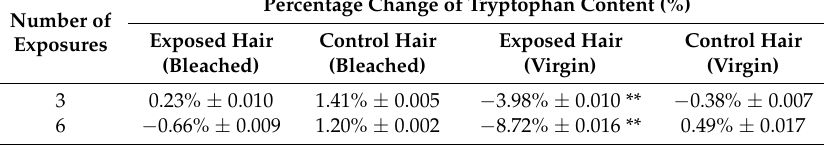
Table 1. Percentage change of the tryptophan content of the experimental and control groups after the third and sixth treatments.